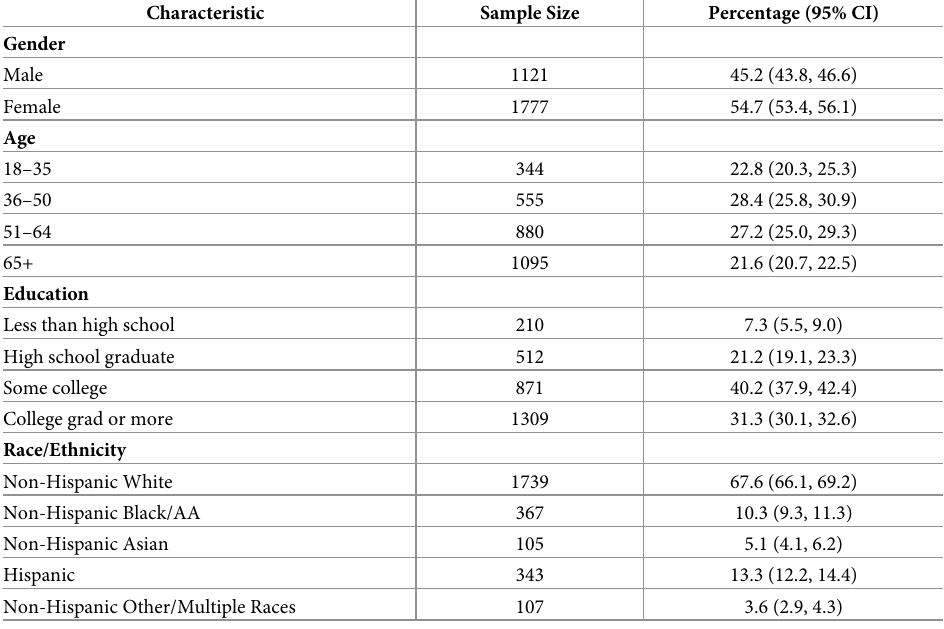
Table 1. Unweighted cell sizes and weighted percentages of the HINTS 5 Cycle 2 sample (n = 2940) of those who visited their provider in the last 12 months and had a valid PCC score.